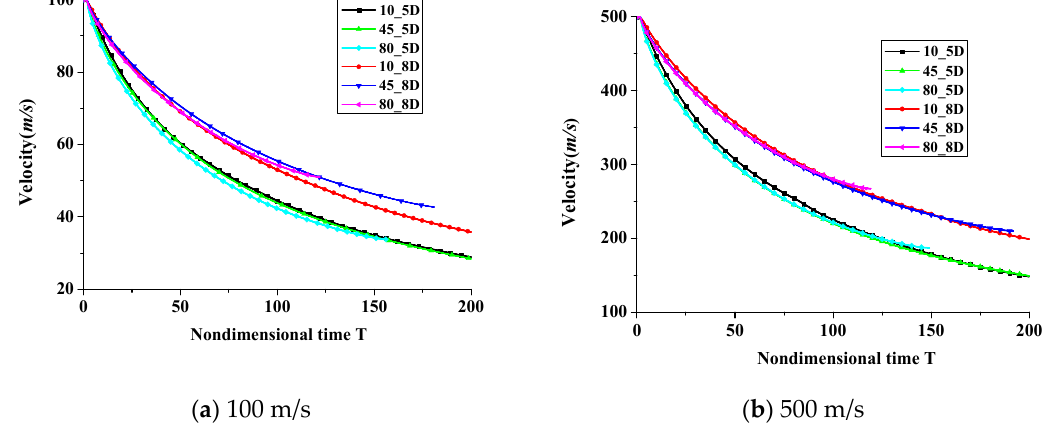
Figure 7. Velocity magnitude variations of water entry with initial velocity of ( a ) 100 m/s, ( b ) 500 m/s.